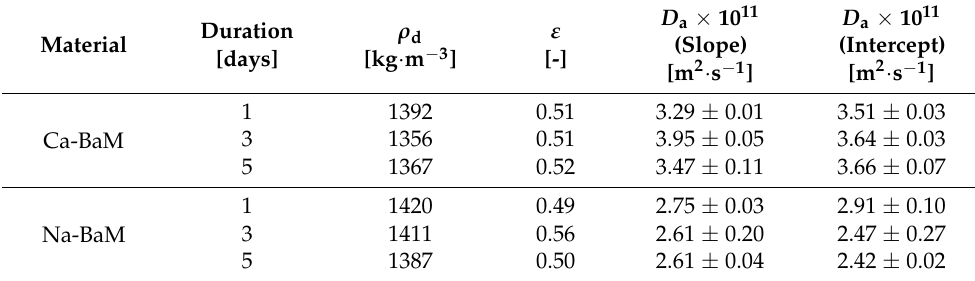
Table 3. Obtained values of apparent diffusion coefficients from planar source diffusion experiments of Sr on compacted Ca- and